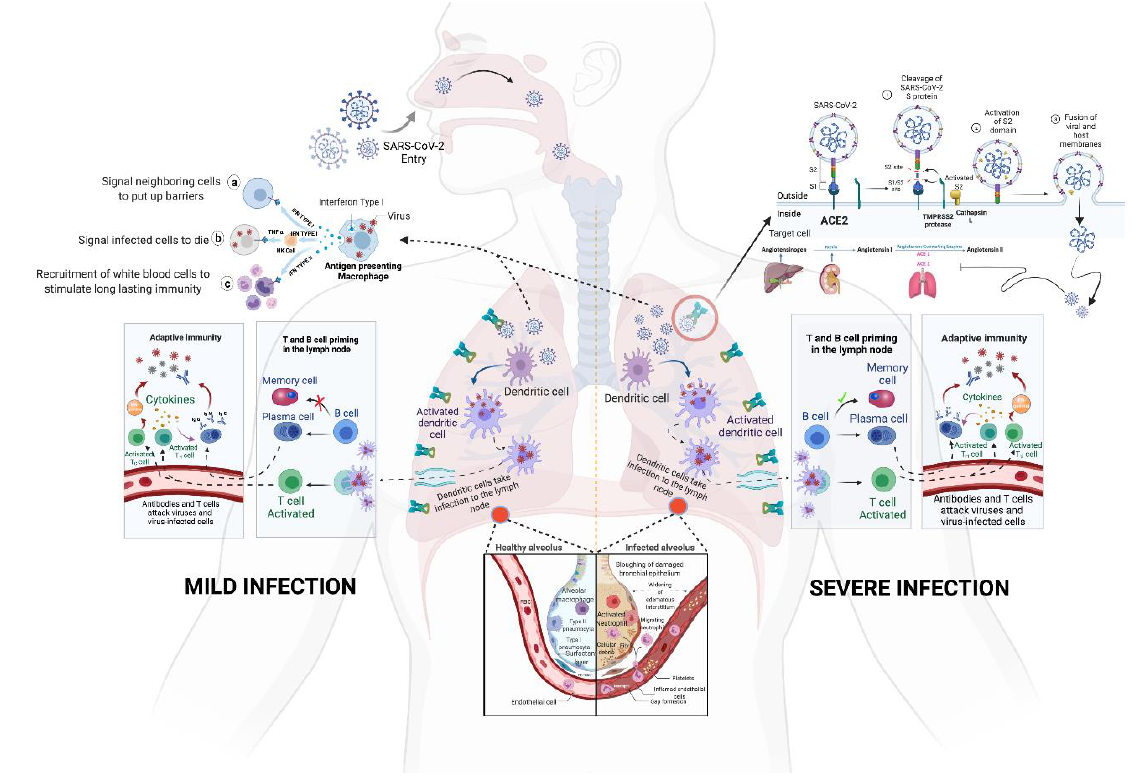
Figure 4. The entry and immunopathology of SARS-CoV-2 in the human body. Adapted from “Mechanism of SARS-CoV-2 Viral Entry, Acute Respiratory Distress Syndrome (ARDS), Adaptive Immunity and Interferons”, by biorender.com ( accessed on 5 January 2022). Retrieved from https://app.biorender.com/biorender-templates; i mage for “memory cell and IFN gamma” from <https://reactome.org/PathwayBrowser/#/R-HSA-168256&SEL=R-HSA-1280218> and image for “ACE2” from https://reactome.org/PathwayBrowser/#/R-HSA-2022377&SEL=R-HSA-2022344&PATH=R-HSA-392499,R-HSA-2980736&FLG=Q9BYF1. Reactome, (all accessed on 30 De- cember 2021).